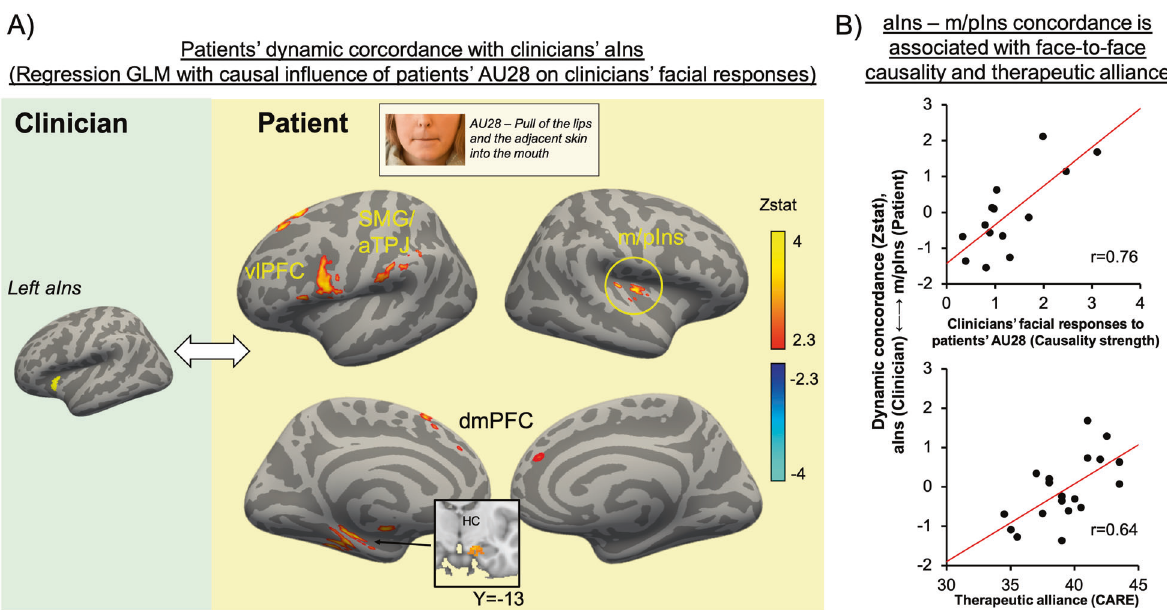
Fig. 4 Association between facial-expression exchange dynamics and brain-to-brain concordance during pain-treatment anticipation. ( A ) A voxelwise GLM regression indicated that the causal strength of patients ’ AU28 on clinicians ’ facial responses overall (across all clinician AUs) was associated with dynamic brain concordance between clinicians ’ aINS activity and patients ’ fMRI activity in the m/pIns, vlPFC, SMG/aTPJ, dmPFC, and the HC. ( B ) Furthermore, dyads characterized by greater aIns (clinician) to m/pIns (patient) concordance also reported greater therapeutic alliance at the preceding clinical intake (Pearson ’ s r = 0.64, p = 0.014). aIns: anterior insula; vlPFC: ventrolateral prefrontal cortex; SMG: supramarginal gyrus; aTPJ: anterior temporoparietal junction; m/pIns: middle/posterior insula; dmPFC: dorsomedial prefrontal cortex;